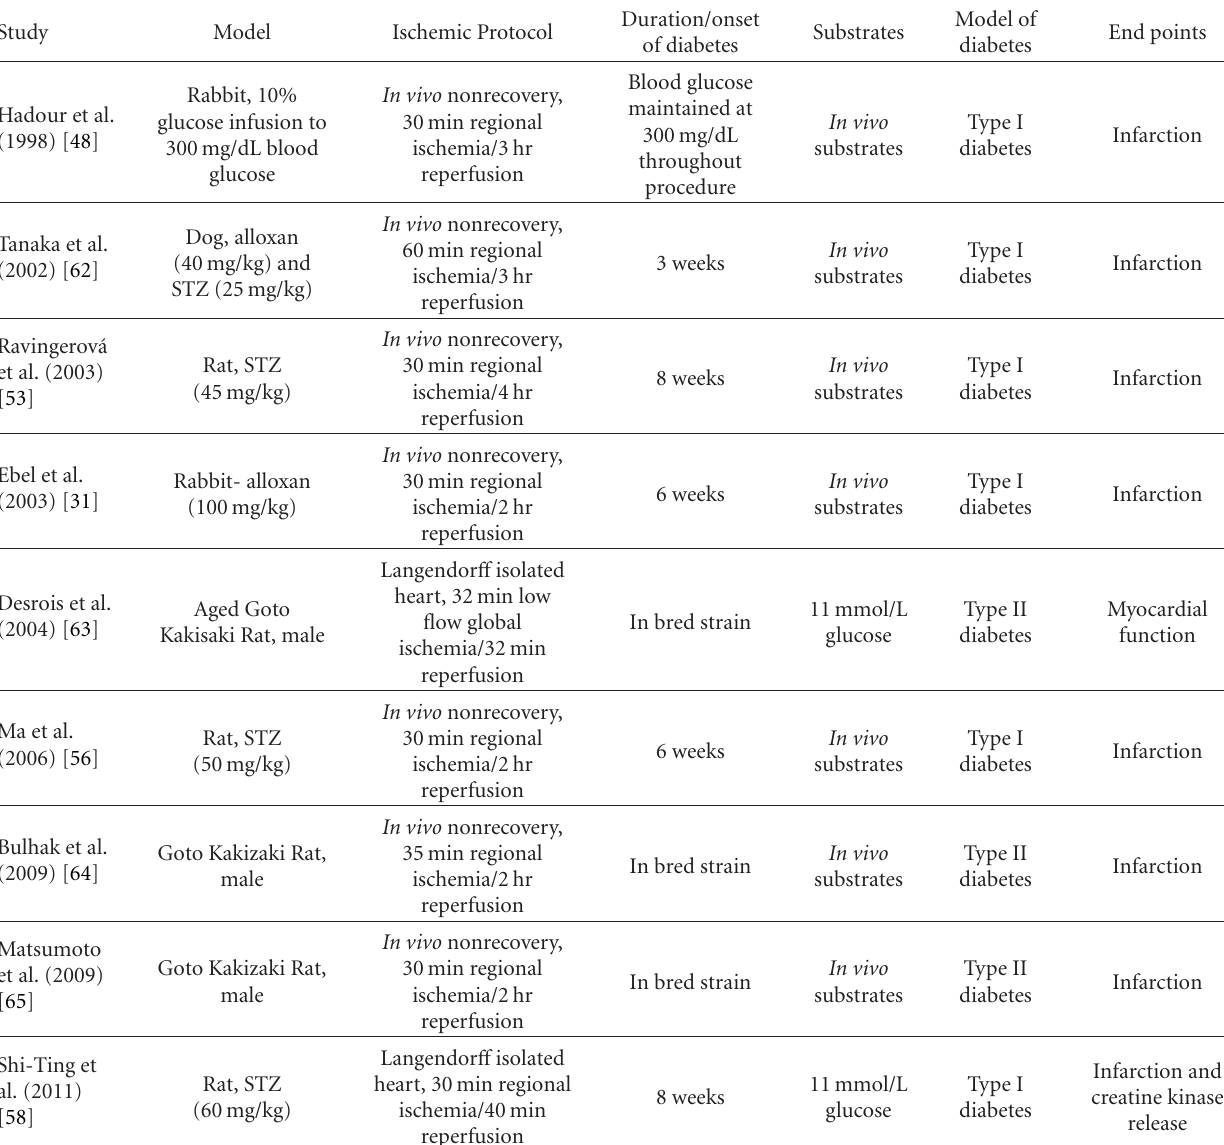
Table 3: Studies indicating no di ff erence in the sensitivity of the diabetic heart to ischemic injury compared to normoglycemic controls. Study End points